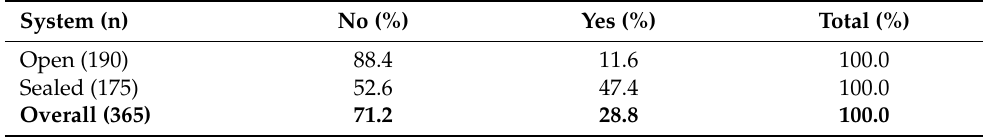
Table 5. Percentage of trees with visually observed wounds with open (plug-less) or sealed (plug) systems for tree injection treatment in green ash ( Fraxinus pennsylvanica Marshall) trees for emerald ash borer ( Agrilus planipennis Fairmaire) 1